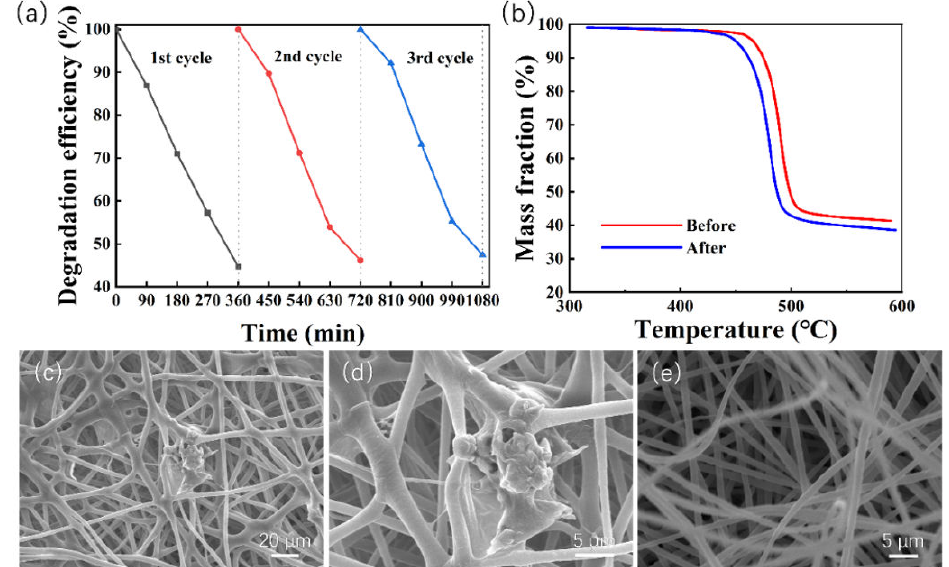
Figure 6. Reusability and stability of the ZnO@PVDF composite membrane (ZnO/PVDF = 1:3, w / w ). ( a ) Three degradation cycles of MO solution using the composite membrane (ZnO/PVDF = 1:3, w / w ) under ultrasonication at room temperature. ( b ) TG curves of the ZnO@PVDF composite membrane before and after ultrasonic treatment for three cycles. ( c – e ) SEM images of the composite membrane after three-cycle